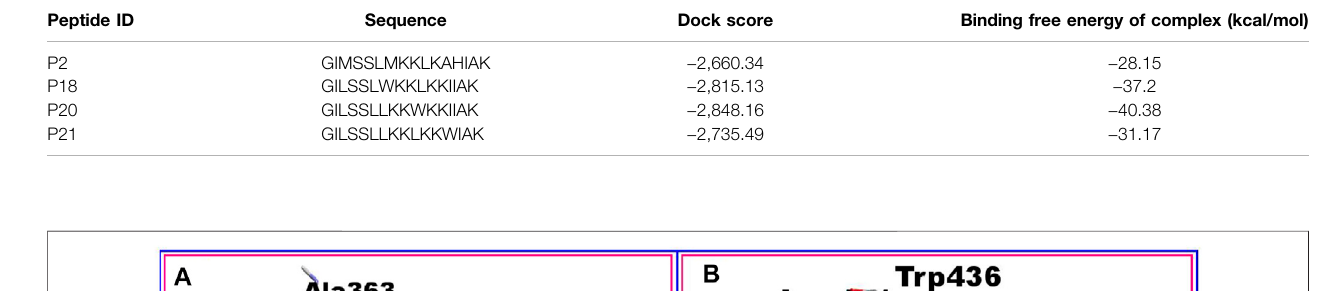
Frontiers in Molecular Biosciences |